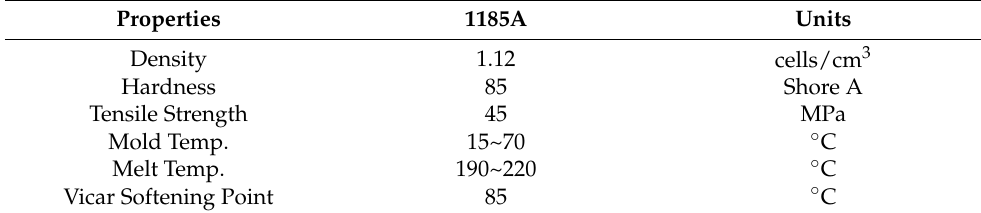
Table 1. Properties of BASF 1185A